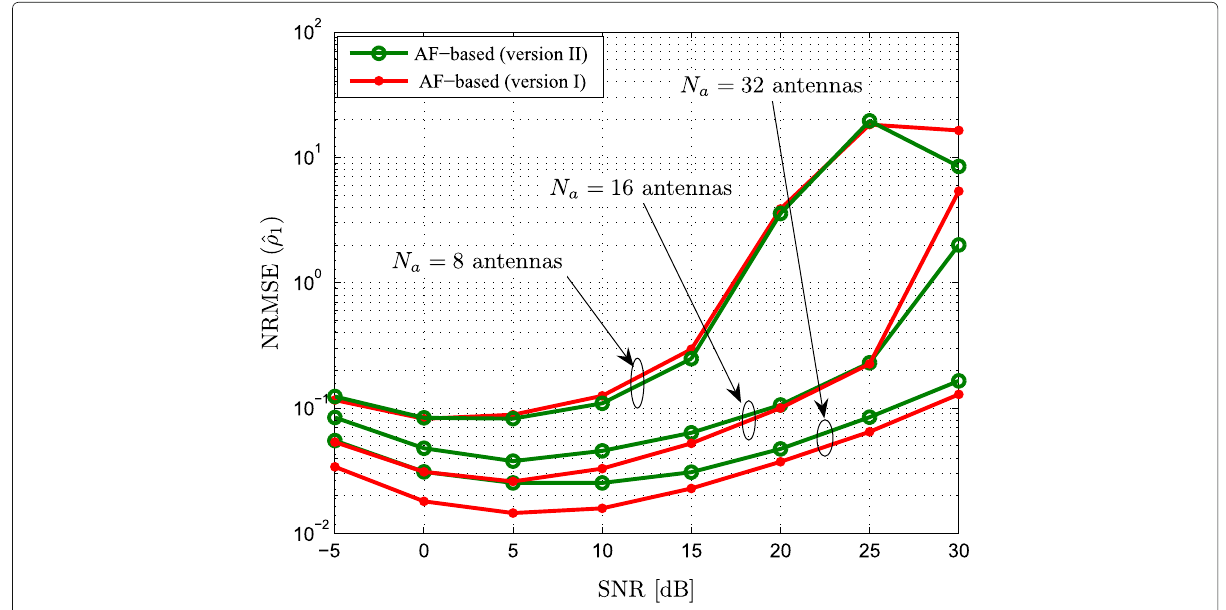
Fig. 10 NRMSE of the SNR estimators ( versionsI and II ) with θ 1 = 18°, θ 2 = 36°, K = 2, N a = 8, 16, 32, and N =